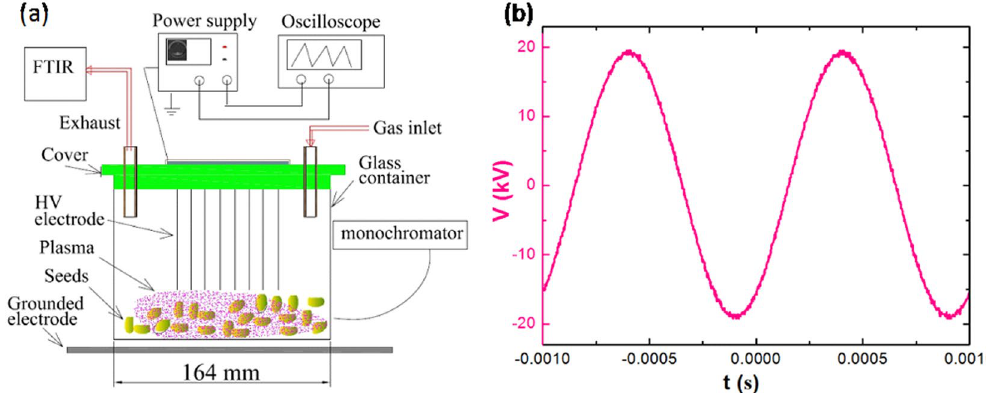
Figure 1. ( a ) Schematic diagram of the experimental setup and ( b ) applied voltage waveform for air and N 2 flow